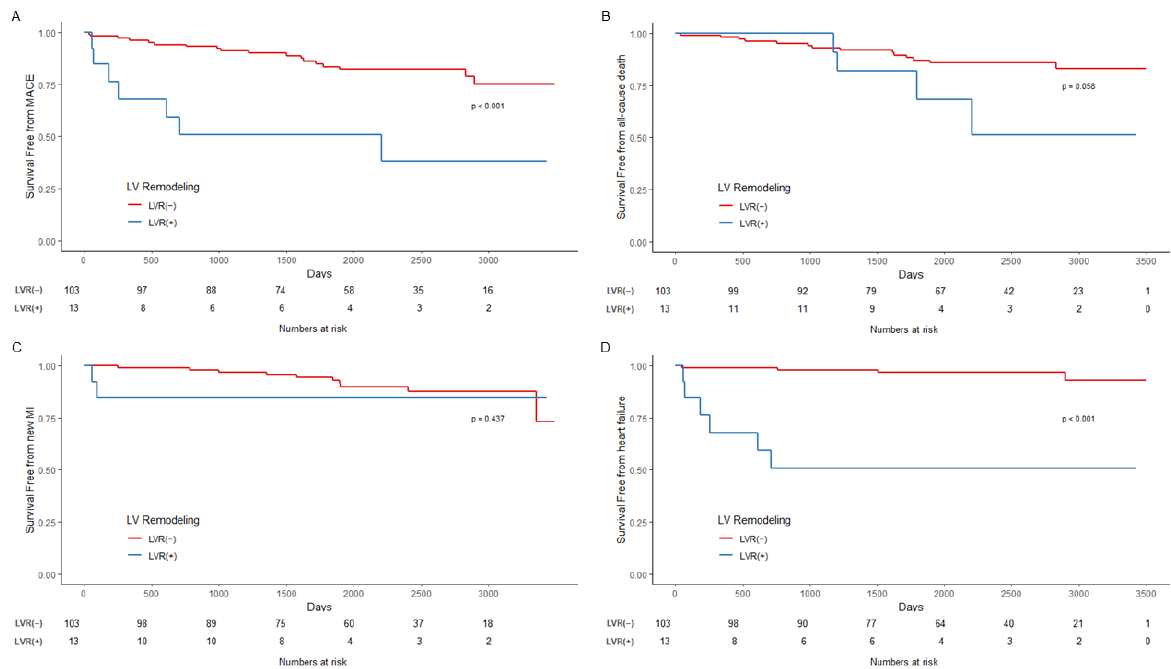
Figure 4. Kaplan – Meier curves for outcomes in patients who had complete revascularization. ( A ) Composite outcome of all-cause death, myocardial infarction, and readmission due to heart fail- ure, thus MACE; ( B ) All-cause death; ( C ) Myocardial infarction; ( D ) Readmission due to heart failure. LVR = left ventricular remodeling; MACE = major adverse cardiovascular outcome; MI =